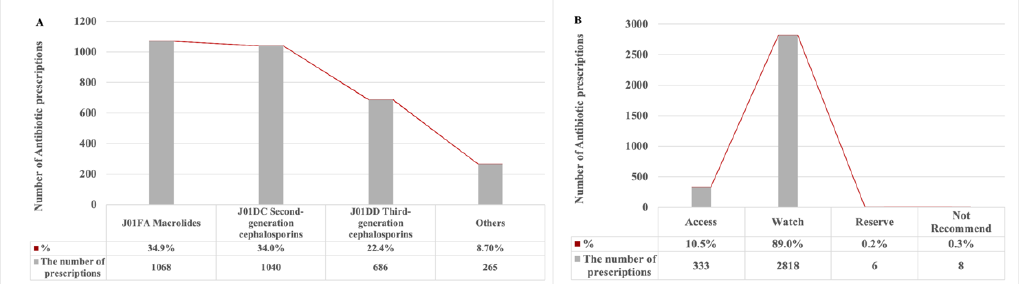
Figure 1. Patterns of antibiotic use among children, as described in the Anatomical Therapeutic and Chemical classification and the 2020 WHO EMLc Access, Watch, Reserve (AWaRe) grouping. ( A ).Patterns of antibiotic use among children described in the Anatomical Therapeutic and Chemical classification. ( B ). Patterns of antibiotic use among children described in the 2019 WHO EMLc Access, Watch, Reserve (AWaRe) grouping.